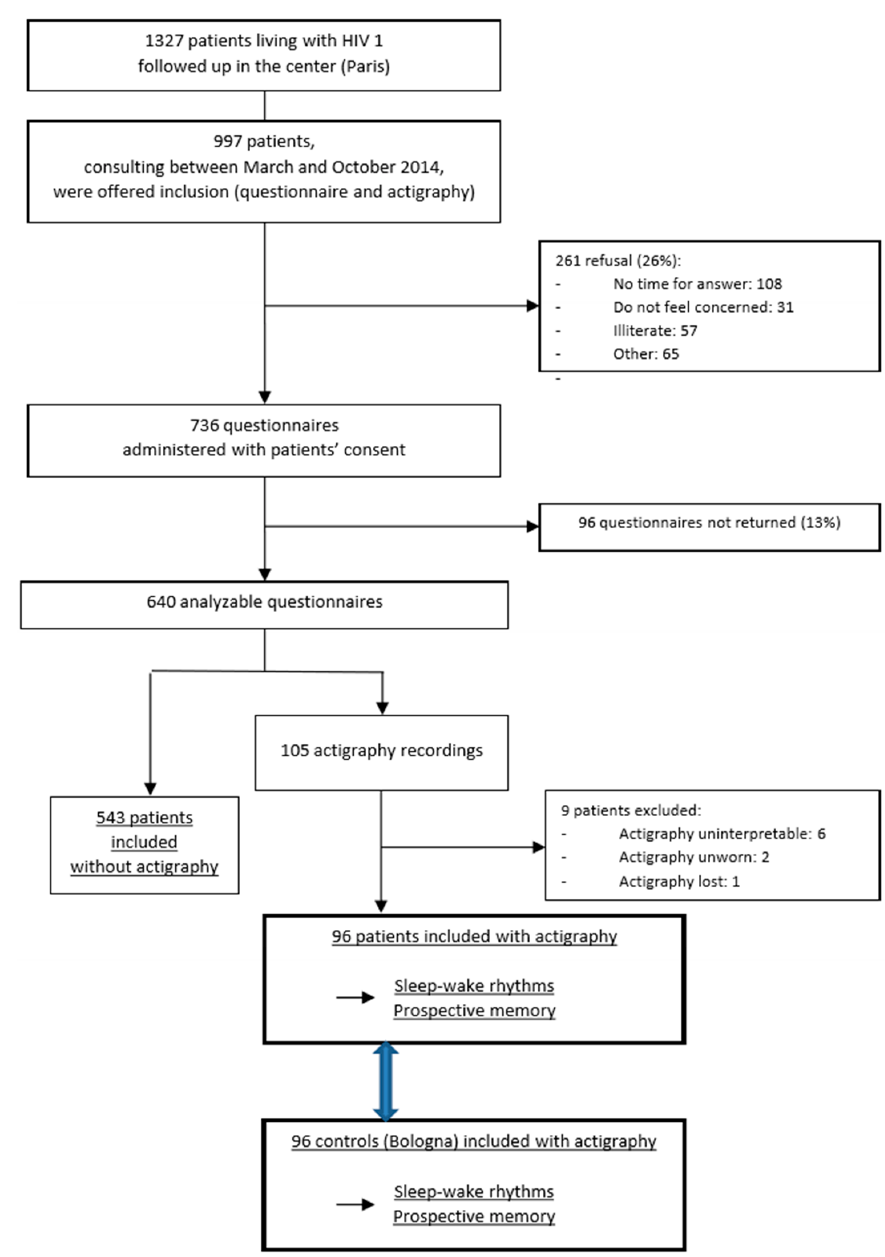
Figure 1. Flow chart of the study.